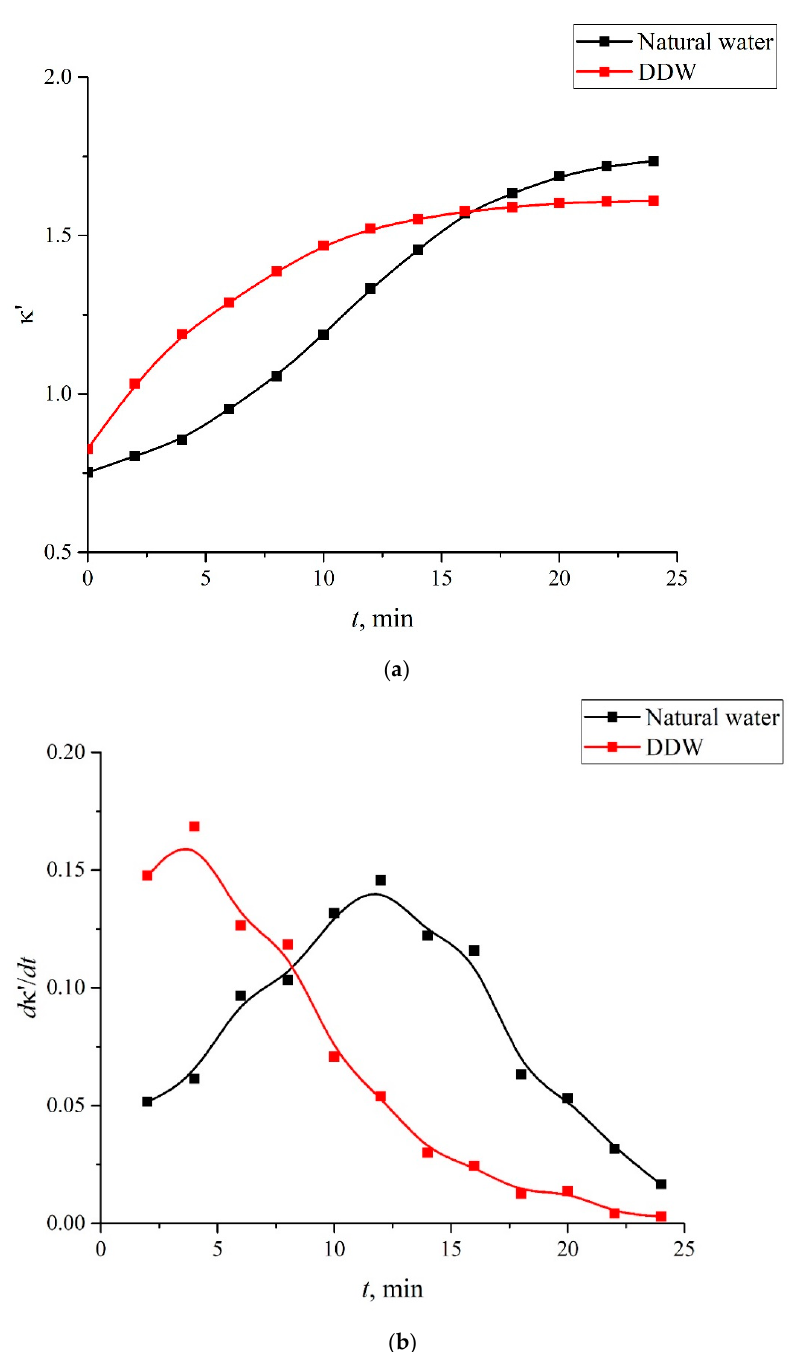
Figure 9. Dynamics of drying the Nafion plate after soaking in the MB solution based on natural water (black curves) and DDW (red curves). Panel ( a )—dependences κ ‘( t ). Panel ( b )—dependences d κ ‘/ dt .